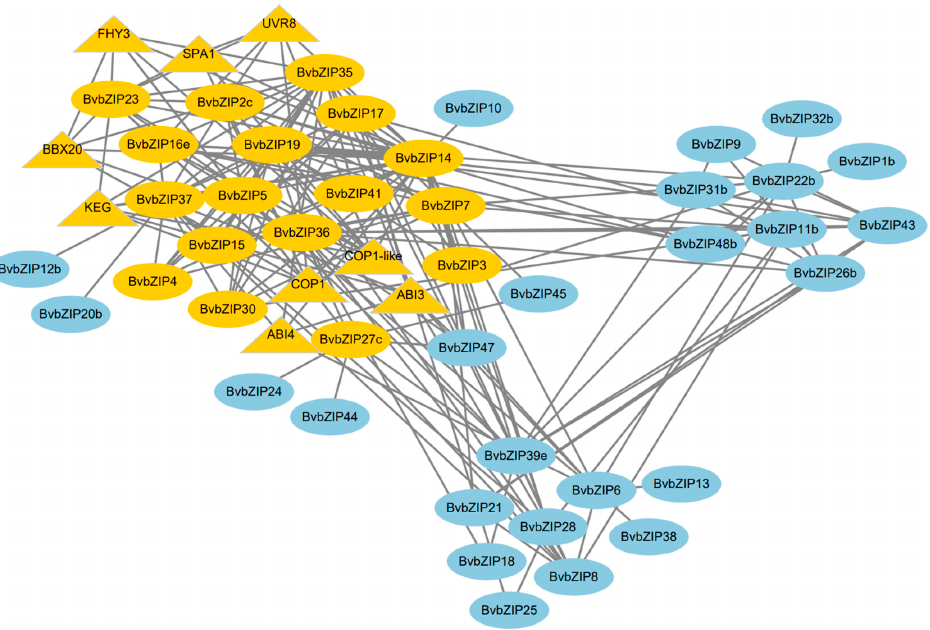
Figure 10. Interaction network of Bv bZIP proteins. The key modules of the network are colored in yellow, and triangles represent other proteins that interact with Bv bZIP protein.